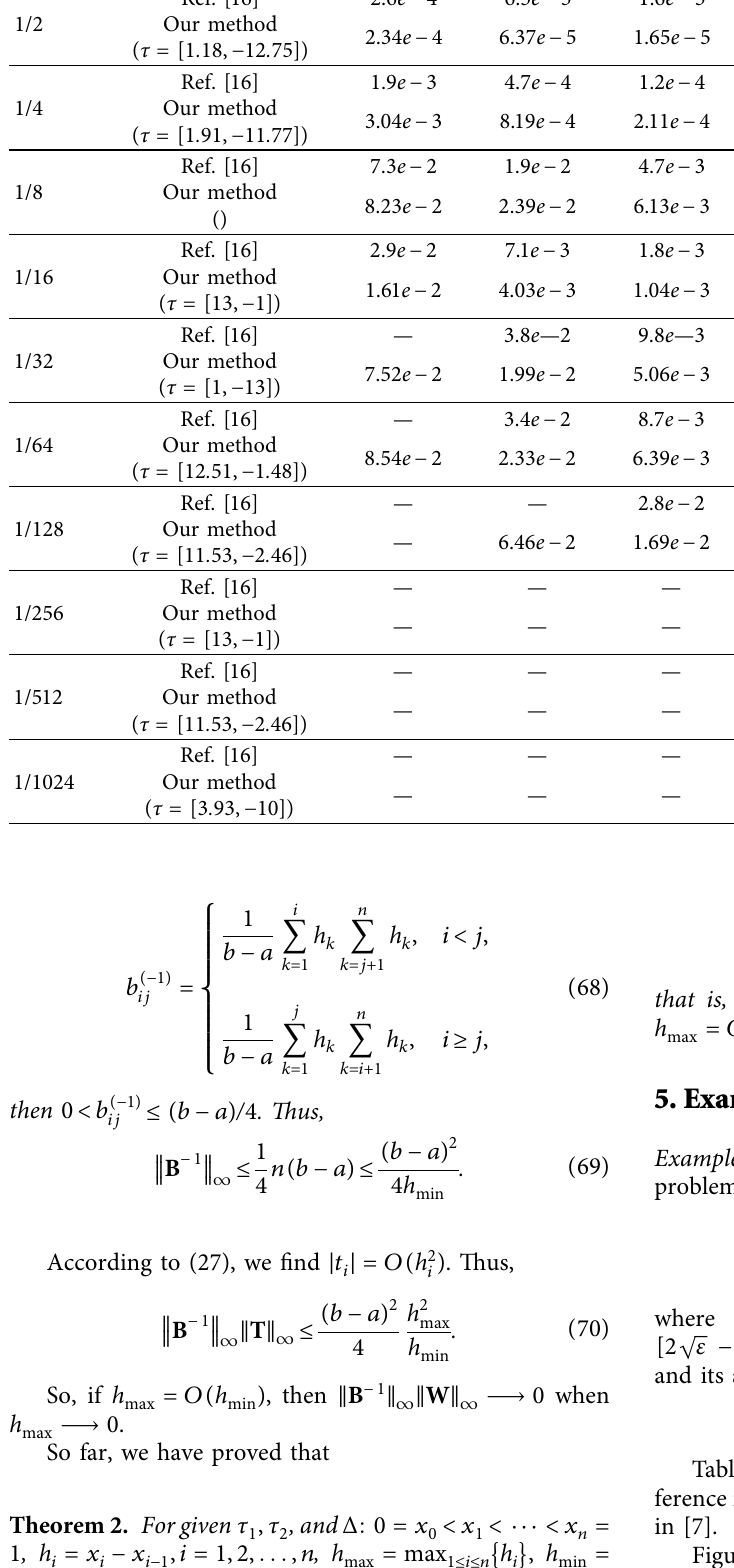
Table 3: The maximum error ‖ E ‖